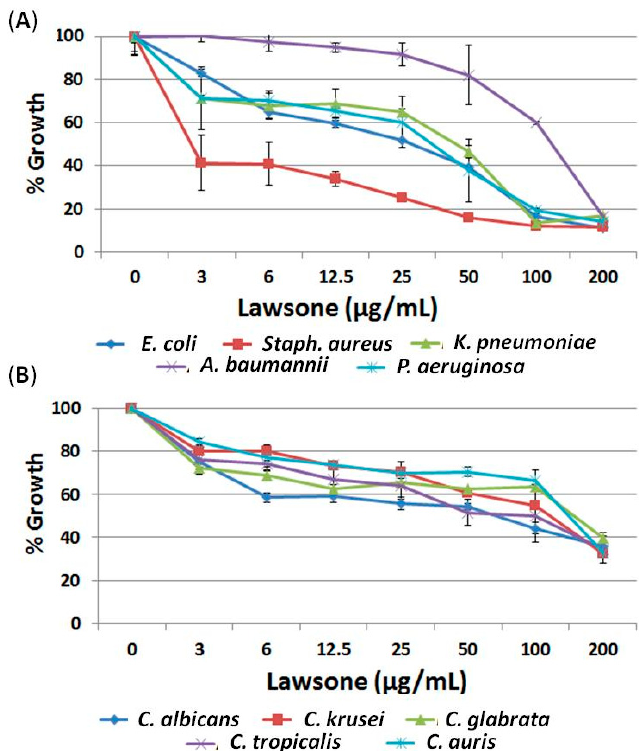
Figure 1. Antibacterial and anti- Candida effects of lawsone. The effect of different lawsone concentrations on ( A ) Gram-negative and Gram-positive bacteria, and ( B ) different Candida spp. Lawsone at 200 µg/mL caused significant inhibition of the growth of all tested bacterial spp. and Candida strains down to ~>90% and 60%, respectively. The data display the mean of the percentage of microbial growth at different concentrations ± standard error of the mean.